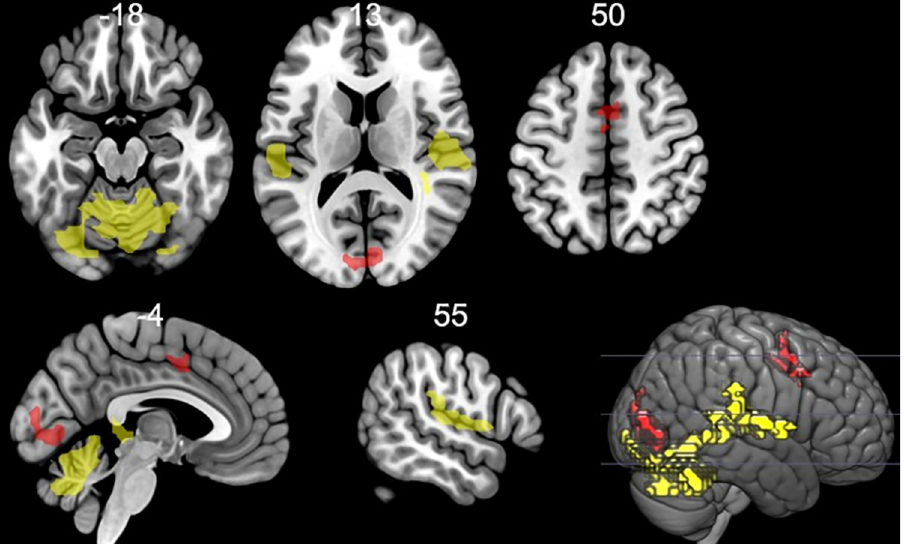
Fig 2. Significant activations to pain anticipation (pain cue vs. no pain cue—red) and perception (painful vs. non- painful stimulus—yellow). Significant activated clusters are shown at pFWE < 0.05. Coordinates are in Montreal Neurological Institute (MNI) space. Statistical maps were visualized on the MNI 152 template brain provided in MRIcroGL (http://www.mccauslandcenter.sc.edu/mricrogl/) [58].